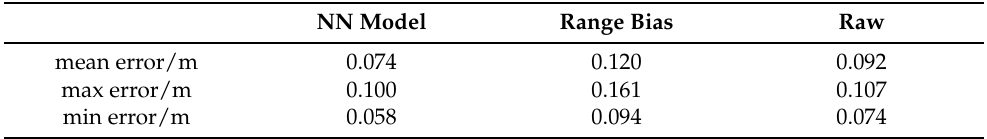
Table 6. Mean, max and min error for all six tags’ poses for the presented model, non-orientational method and raw measured